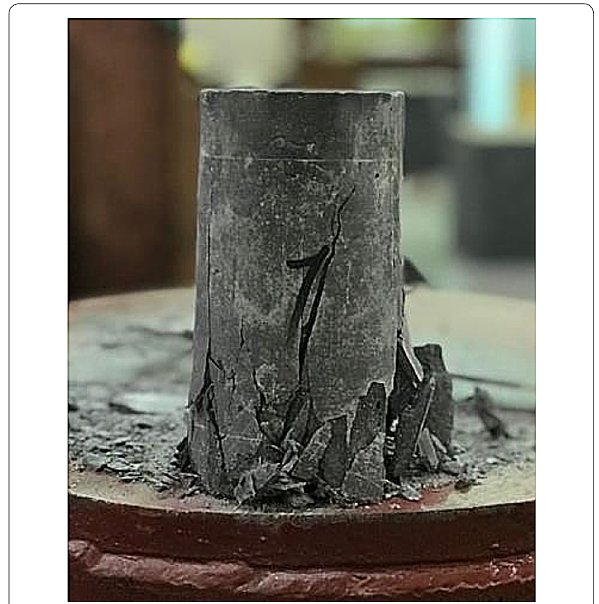
Fig. 13 Formation of cracks and UHPFRC (T3) steel fibers at failure of compression tests